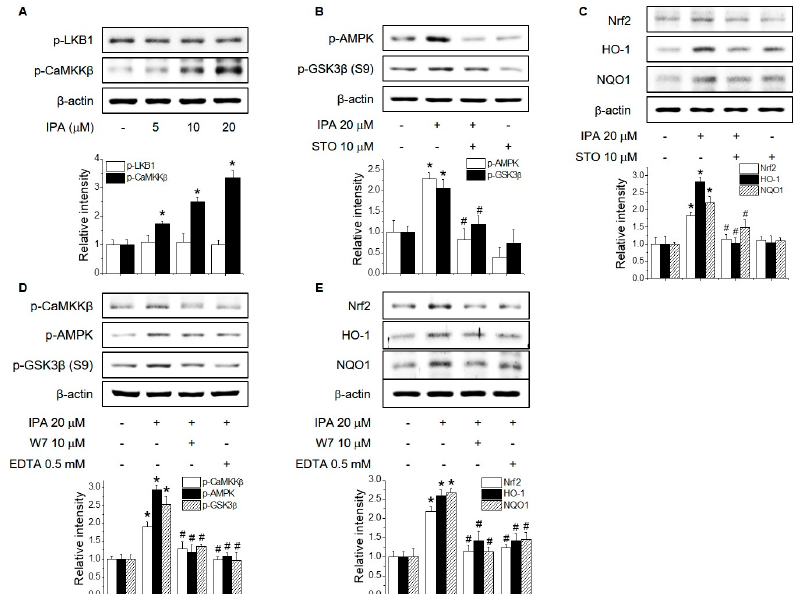
Figure 4. Role of CaMKK β in IPA-induced Nrf2 expression via the AMPK/GSK3 β signaling pathway. ( A ) RAW264.7 cells were treated with 5–20 µ M IPA for 15 min. LKB1 and CaMKK β phosphorylation levels were determined by Western blotting. ( B ) RAW264.7 cells were cultured with 10 µ M STO-609 for 1 h before adding 20 µ M IPA for 30 min. AMPK and GSK3 β phosphorylation levels were determined by Western blotting. ( C ) RAW264.7 cells were cultured with 10 µ M STO-609 for 1 h before adding 20 µ M IPA for 12 h. The protein levels of Nrf2, HO-1, and NQO1 were determined by Western blotting. ( D ) RAW264.7 cells were pretreated with 10 µ M W7 or 0.5 mM EDTA for 1 h, followed by 20 µ M IPA for 15 min. CaMKK β , AMPK, and GSK3 β phosphorylation levels were determined by Western blotting. ( E ) RAW264.7 cells were cultured with 10 µ M W7 or 0.5 mM EDTA for 1 h before adding 20 µ M IPA for 12 h. * Significantly different from the control at p < 0.01. # Significantly different from the IPA treatment group at p <